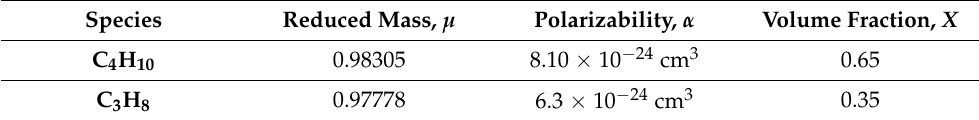
Table 5. Parameters of C 4 H 10 and C 3 H 8 for the calculations of van der Waals broadenings. Species Reduced Mass, µ Polarizability, α Volume Fraction, X C 4 H